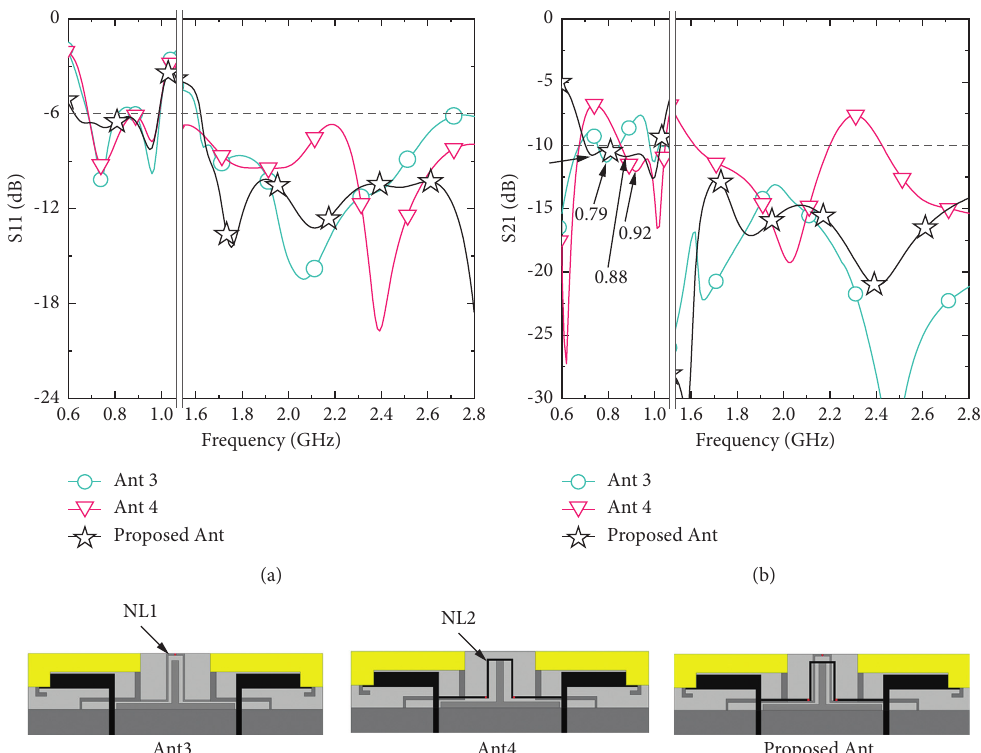
Figure 3: Simulated S-parameters of Ant3 (without NL2), Ant4 (without NL1), and Proposed Ant (with the two NLs). (a) S11. (b) S21.